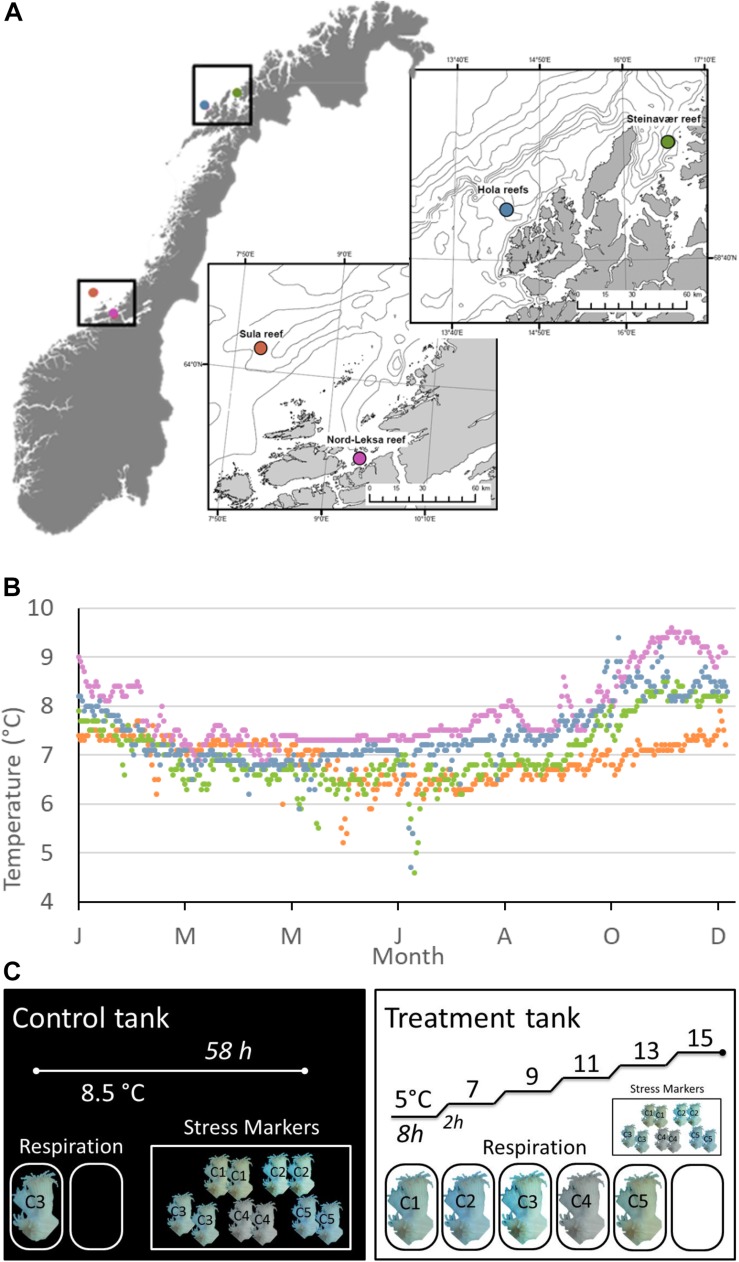
(A) Sampling sites during the POS-525 cruise along the Norwegian coasts and margins. (B) Modeled daily temperatures at the bottom layer of the geographical coordinates through the year 2015 (data provided by the ROMS model NorKyst-800 described by Albertsen et al., 2011). NorKyst-800 is a numerical, high-resolution, ocean modeling system (based on the numerical ocean model ROMS (Regional Ocean Modeling System; http://myroms.org), built to provide environmental information for all coastal areas in Norway as input to a range of applications, such as the movement of oil spills and algae blooms and for looking into factors such as ocean variability. Data from January 1995 to October 2017 are presented in Supplementary Figure S4. (C) Experimental design for each reef (n = 4 reefs sampled). One Control tank (left), where the temperature was kept constant at ambient level (8.5°C) for 58 h and one treatment tank (right), where we increased temperature with a heater from 5 to 15°C by steps (8 h at each temperature step and 2 h increase by +2°C). Five colonies were sampled at each reef: C1–5. Each colony was fragmented for respiration and stress marker analyses. In the Control tank, one randomly chosen fragment (here from C3) was incubated for respiration along with one blank (no coral). In the Treatment tank, one fragment per colony (C1–5) was incubated for respiration, along with one blank. There were six incubations per fragment, one per temperature step. Two fragments from each of the five different colonies (C1, C2, C3, C4, C5) were used as a baseline (Control Tank): one for the neutral red assay and the second for the lipid peroxidation assay. The same design was used for testing the Treatment effect on the stress markers (right). Fragments for stress markers were kept in the tanks from the beginning of each experiment and sampled for analysis at the end of the incubations (58 h).